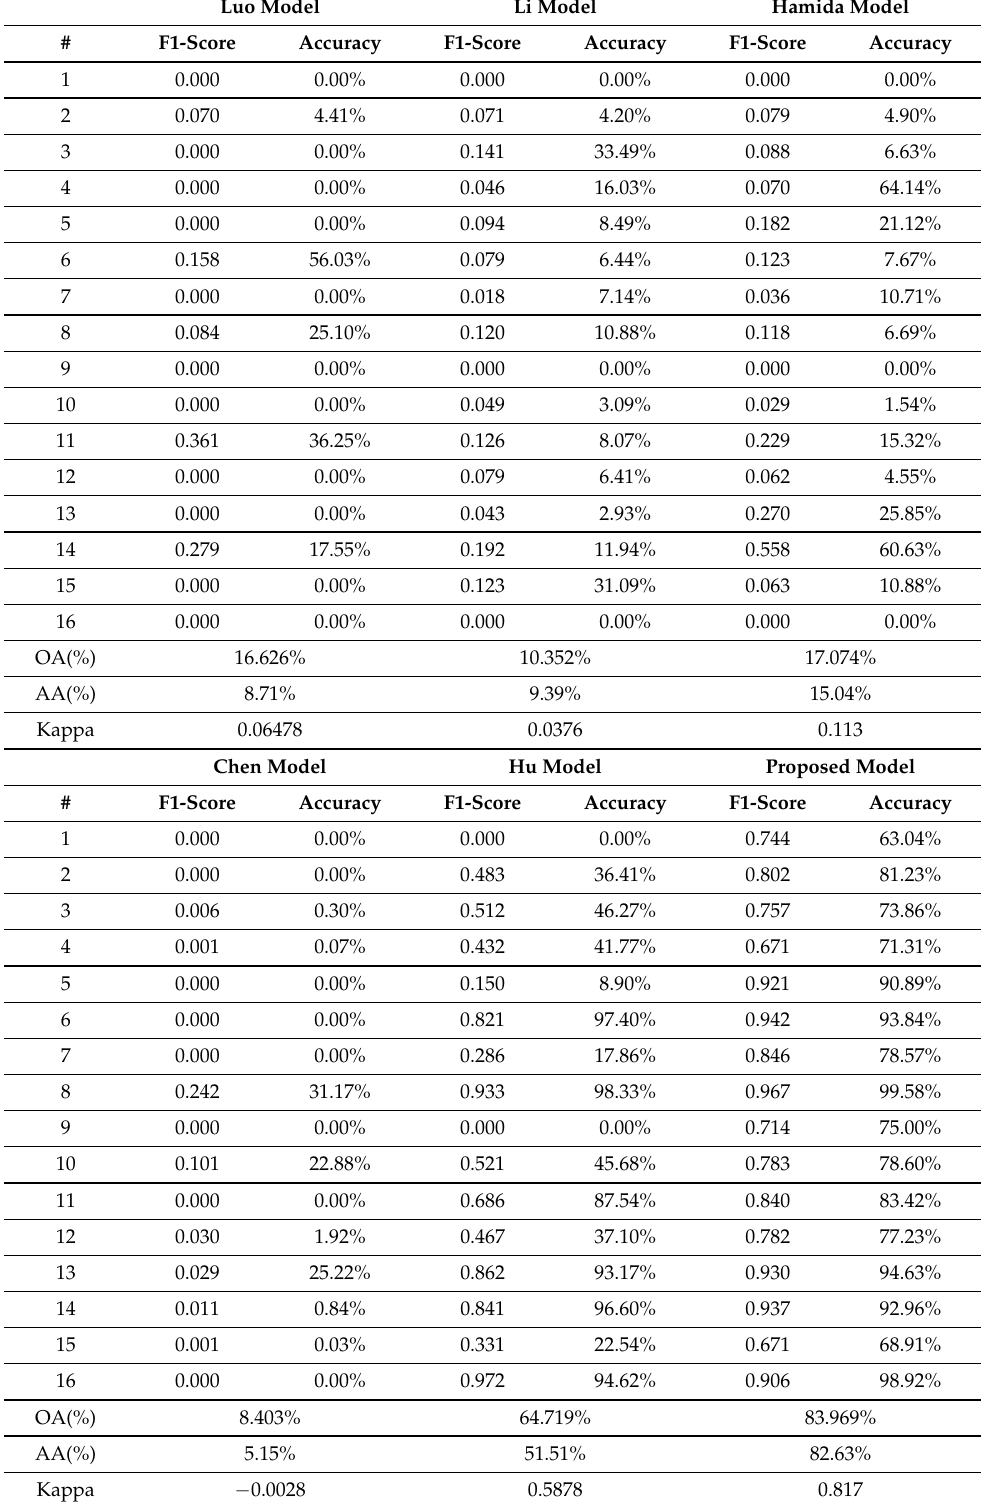
Table 13. Classification results of the Indian Pines dataset to which random spatial information is not applied for training and random spatial information to